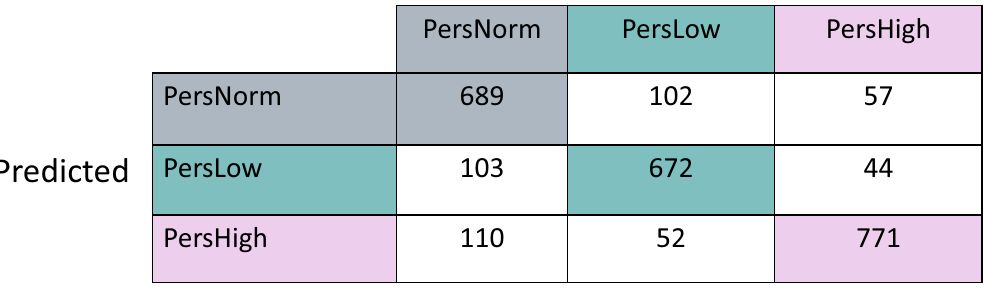
Table 2). Exclusion criteria included cancer, COPD, cardiovascular disease, food allergies, or any antidiabetic drug use.